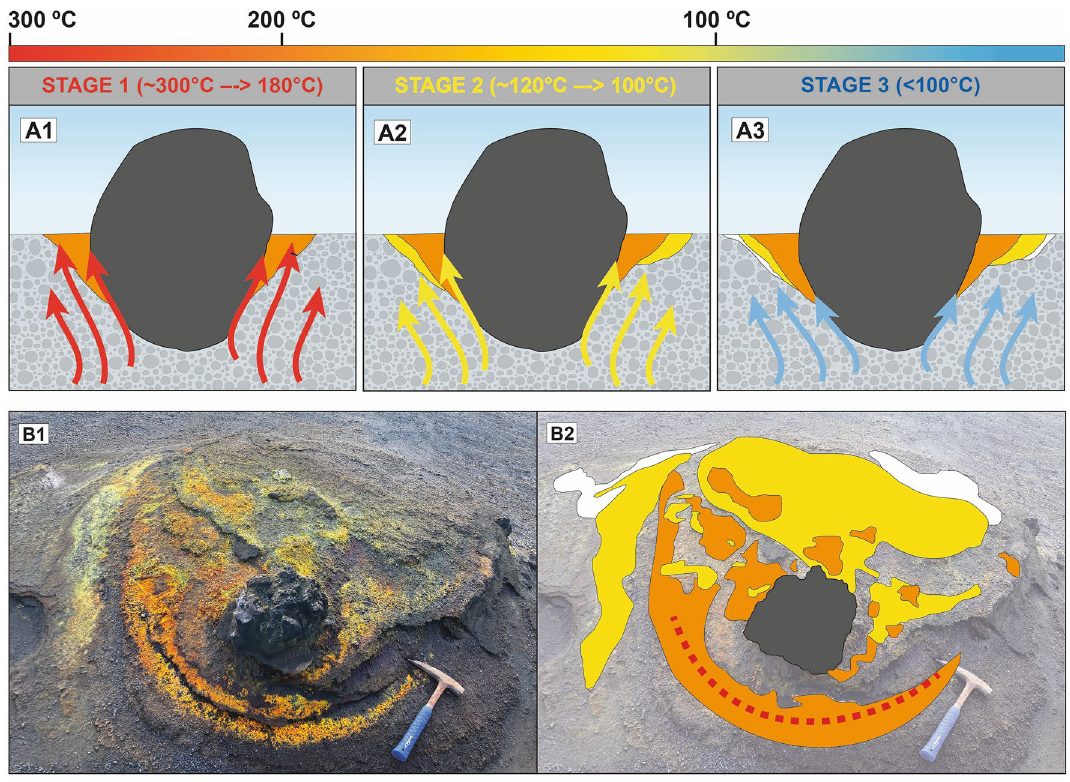
Figure 8. ( A ) Schematic model of the formation of the Tajogaite fumarolic mineralization according to different stages of cooling. ( B ) General view of a fumarolic outcrop developed around an erratic block. It is possible to distinguish the typical mineral sequence developed during cooling in Tajogaite, with occurrence of mineral assemblages of (1) medium temperature (MT) fluorides and chlorides (~ 300–180 °C); (2) low temperature (LT) native sulphur in association with other accessory phases (e.g., gypsum, mascagnite and salammoniac) (~ 120–100 °C), and lately (3) low temperature (LT) sulphates and alkaline carbonates related with the lowest temperature conditions (< 100